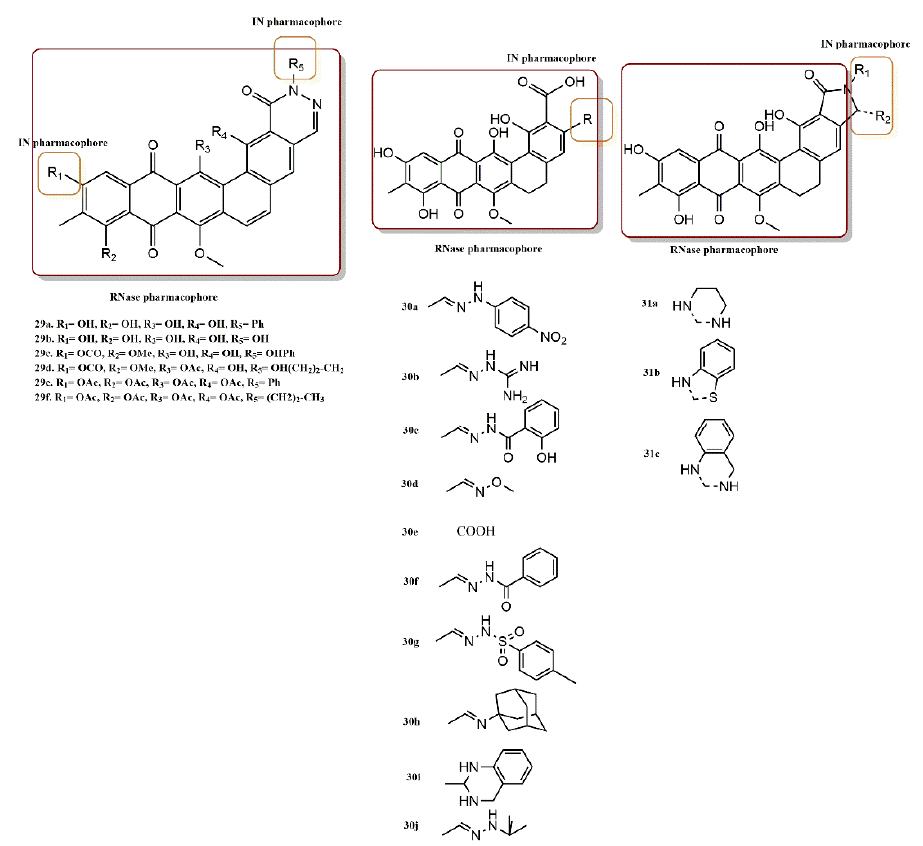
Figure 26. RT and IN pharmacophores of new active synthesized compounds 29a-f , 30a-j, and 31a-c .